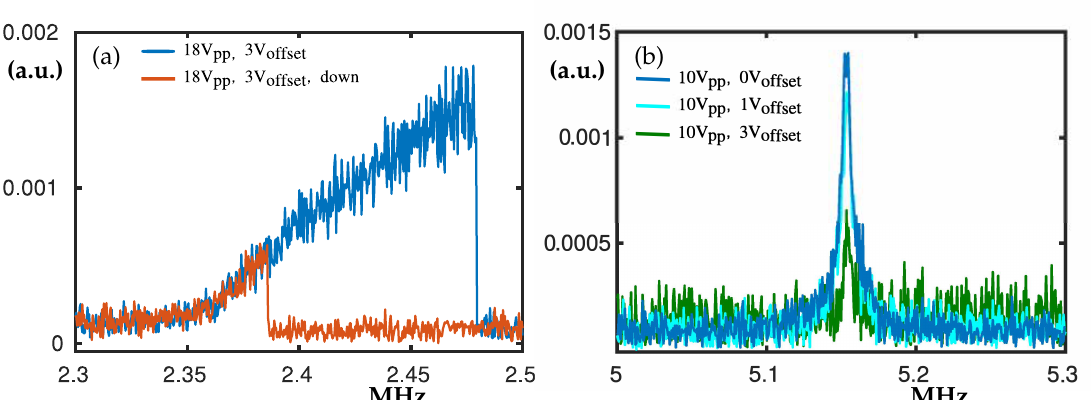
Figure 3. Experimental frequency swipes centred at about 2.37 MHz and 5.15 MHz. In panel ( a ) the blue curve denotes swipe-up and the red curve denotes swipe-down. The excitation AC voltage is 18 V peak-to-peak (V pp = 18 V) and 3 V offset (V of f = 3 V). In panel ( b ) V pp = 10 V where the blue, cyan and green curves denote V of f = 0 V, V of f = 1 V and V of f = 3 V,